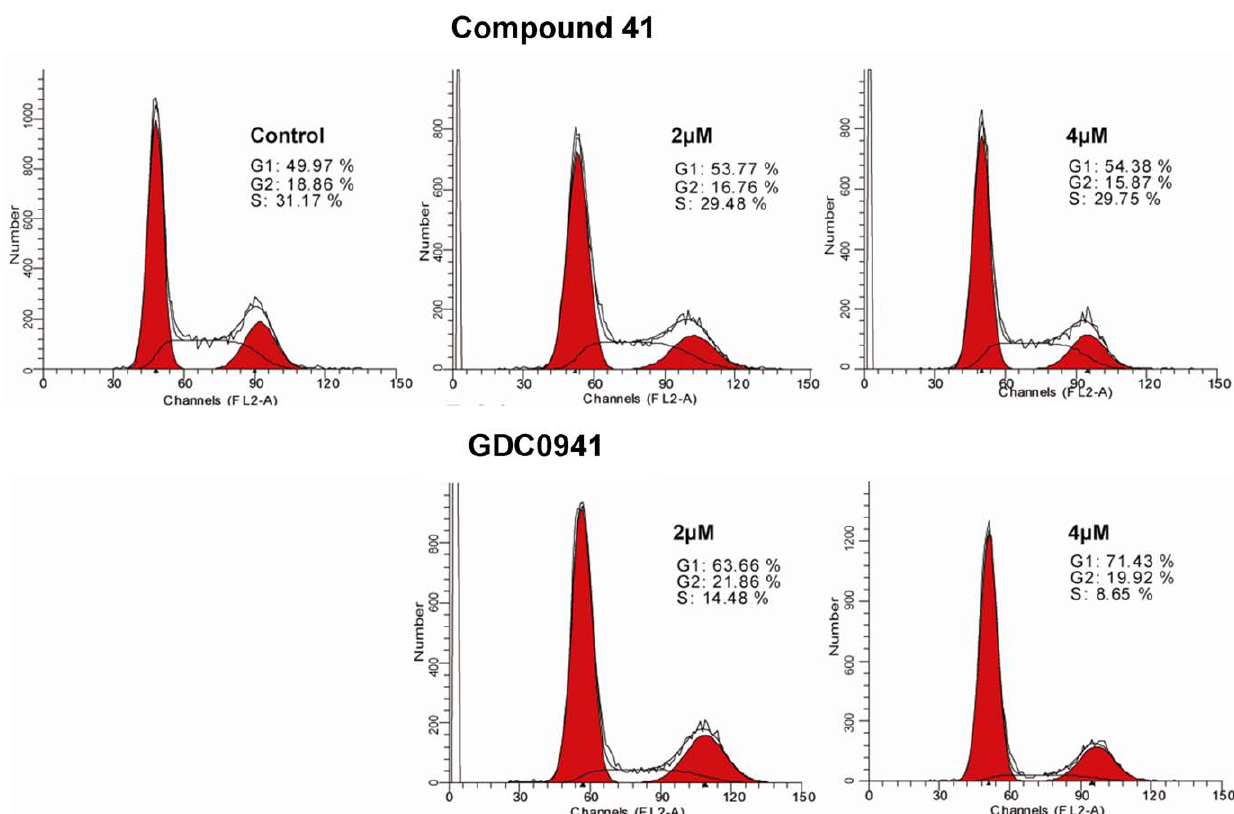
Figure 6. Cell cycle arrest test of compound 41 and GDC0941 in PC3 cells. Vertical axes stand for the counts of relative number of PC3 cells; horizontal axes stand for the relative fluorescence light intensity measured as pulse-area (FL2-A).